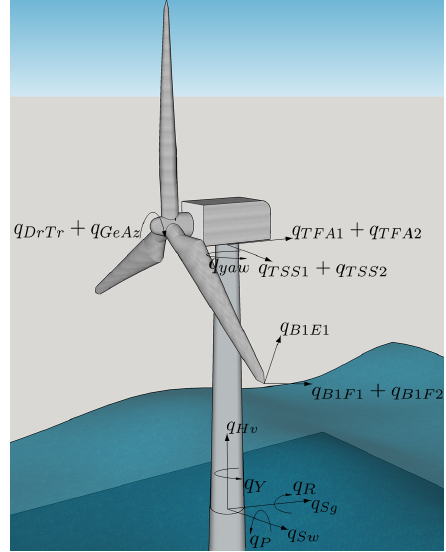
Figure 1. Schematic diagram of the degrees of